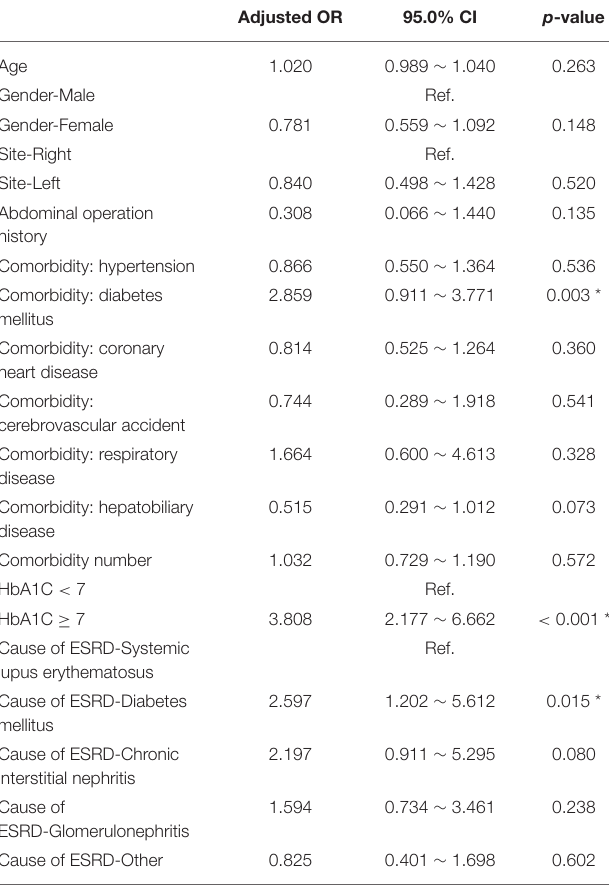
TABLE 3 | Multiple logistic regression analysis of factors influencing infection after catheter